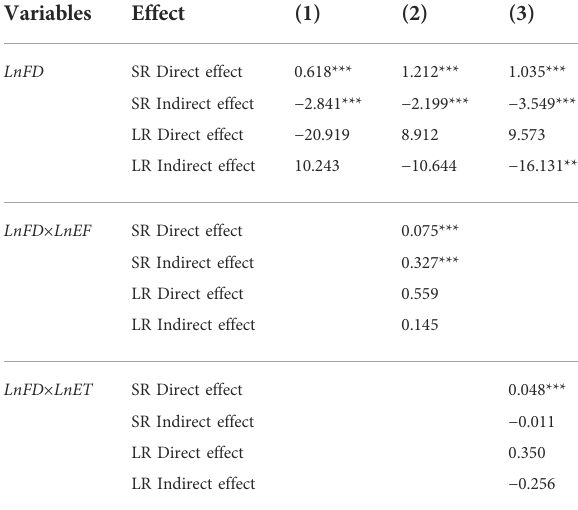
TABLE 8 Results of the direct and indirect